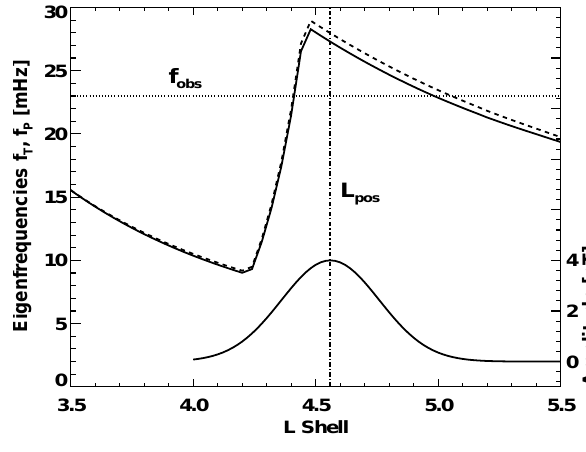
Fig. 13. Assumed plasma background conditions. The plasma density is calculated from modeling the electron density. Plasma pressure, β and current density are assumed for quiet geomagnetic activity.